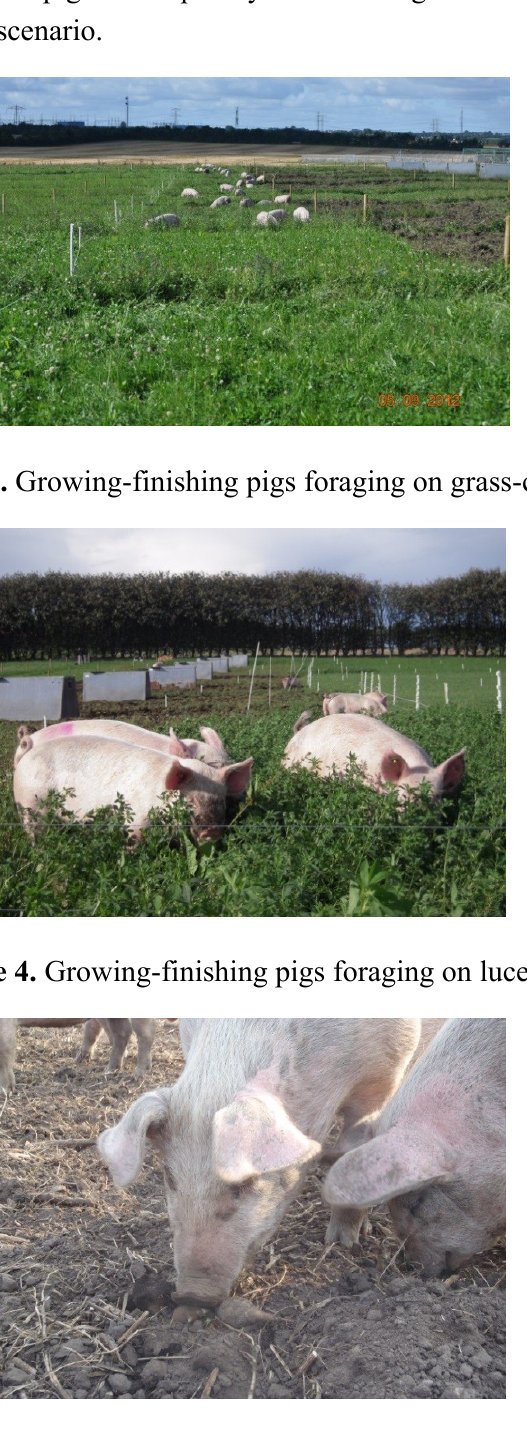
Figure 5. Growing-finishing pigs foraging on Jerusalem